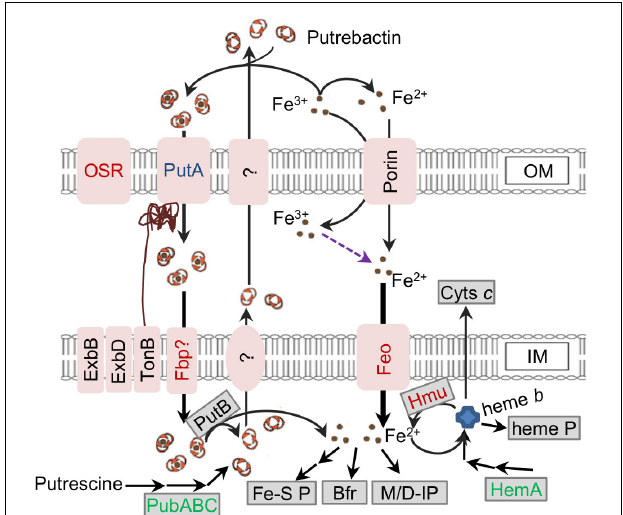
FIGURE 1 | Model for iron homeostasis in S. oneidensis . Fe 2 + (in the environment and from reduction of Fe 3 + ) can be imported across IM primarily mediated by Feo as the major route of iron uptake. Additionally, Fe 3 + can be scavenged by siderophore (putrebactin, produced from putrescine by PubABC and secreted via unknown pathway) to form Fe 3 + -siderophore complexes. The complex enters the periplasm through PutA, and then cross IM via unconfirmed ABC transporter (Fbp?, FbpABC). Fe 3 + may also be captured by some other bacterial siderophores present in the environment, which enter the cell through other siderophore receptors (OSR). In the cell, Fe 2 + is released from the complex after the reduction catalyzed by PutB. Fe 2 + can be stored in Bfr, assembled into Fe-S proteins (Fe-S P) and heme b as well as work as a co-factor for mono/di-iron nuclear proteins (M/D IP). Heme b can be assembled into heme proteins (heme P) and cyts c , and degraded to release Fe 2 + by HmuRSO (Hmu). Increased, unchanged, and reduced abundance (1.5-fold) in the fur mutant based on the proteomic data are in red, blue, and